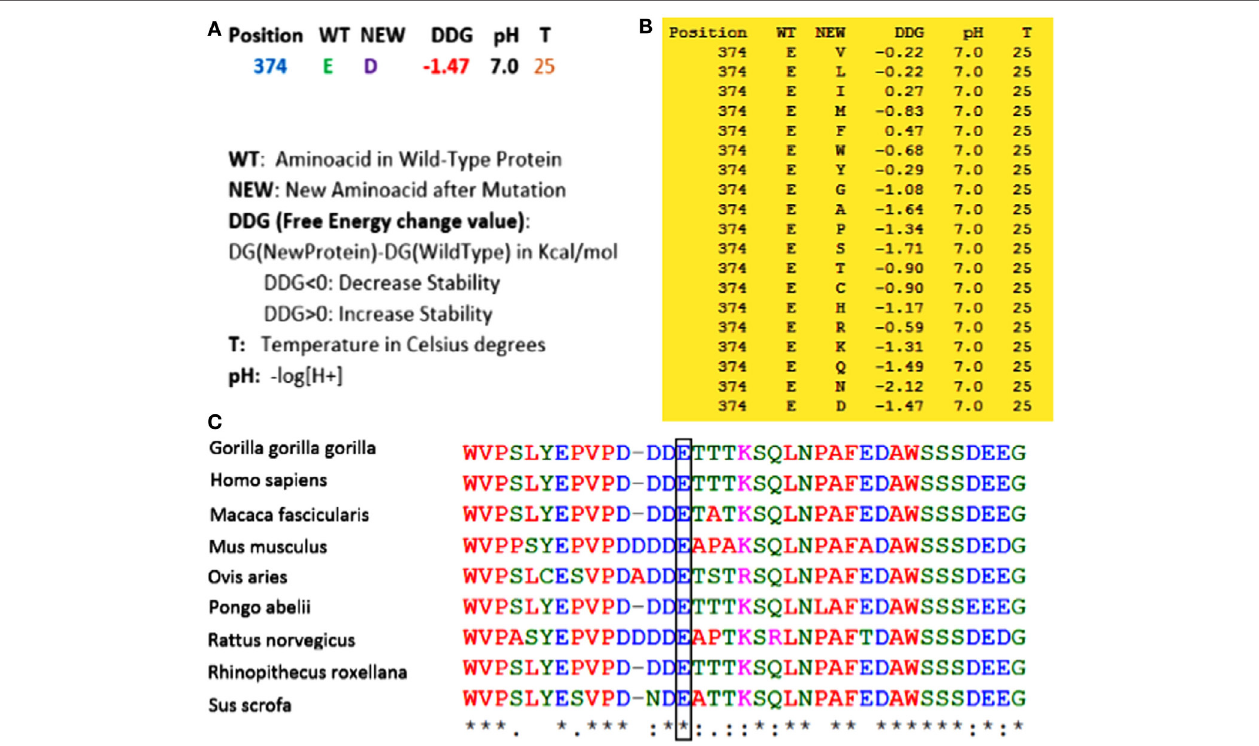
FIGURe 4 | (a) By using I-Mutant v2.0, it was revealed that with the substitution from Glu 374 to Asp, the stability of the protein will be decreased. (B) All alterations of stability for all other amino acids in this residue were also predicted by this program. As can be seen, most of the substitutions in this region can decrease the stability of the protein. (C) Comparative amino acids alignment of ERCC8 protein across Kingdoms shows that the Glu374 residue is highly conserved during evolution. The conserved Glu (E) residue is shown in the rectangular box. Protein sequences were obtained from National Center for Biotechnology. Symbols: (*)—identical amino acids; (:)—just similar amino